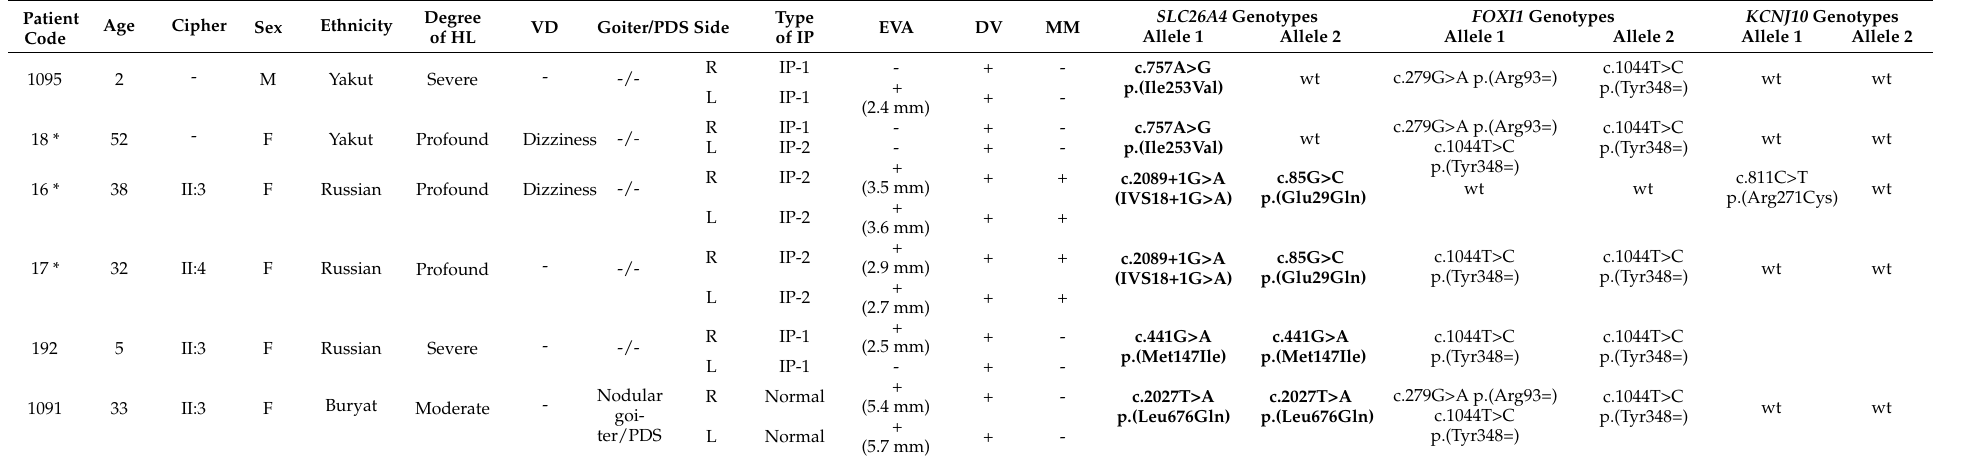
Table 2. Clinical and molecular genetic characteristics of patients with the studied inner ear